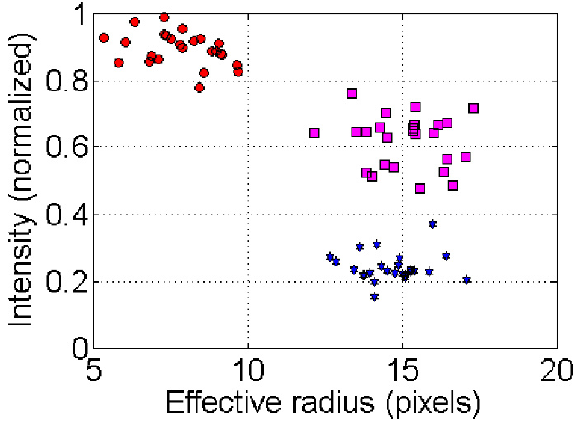
FIGURE 5: Illustration of nuclei distribution according to intensity and effective radius . Nuclei will affiliate to apoptotic, non- apoptotic, or intermediate states according to the values of their effective radius and intensity parameters. Red circles correspond to apoptotic nuclei (high intensity and low effective radius area); blue stars correspond to non-apoptotic nuclei data (low intensity and high effective radius area); magenta squares correspond to intermediate states (higher intensity and similar effective radius area compared with non-apoptotic nuclei).